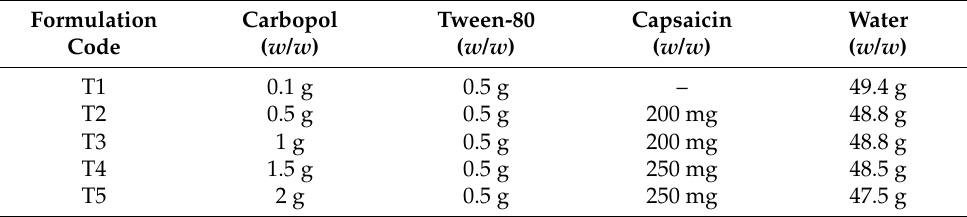
Table 1. Compositions of Capsaicin Nano-crystals ( w / w ).